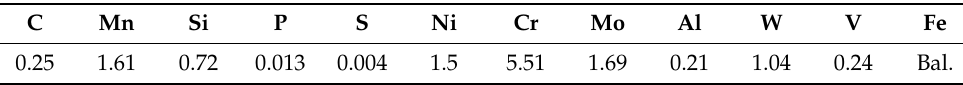
Table 3. Chemical composition of ferrous welding materials RMD248 used in this study, mass/%.